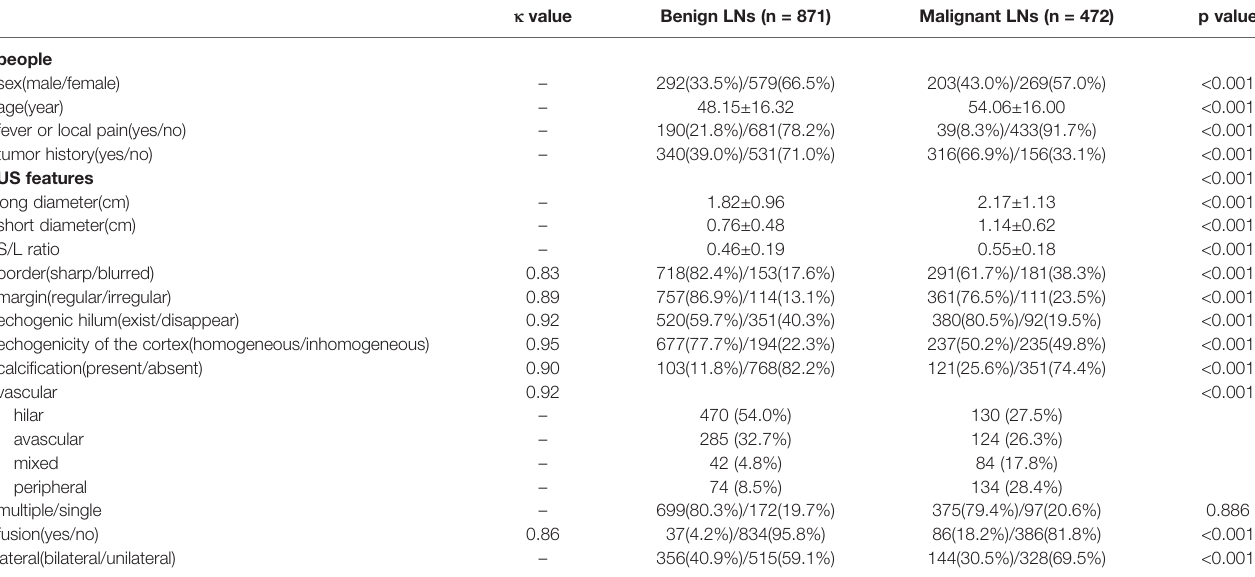
TABLE 2 | Univariate analysis of benign and malignant lymph